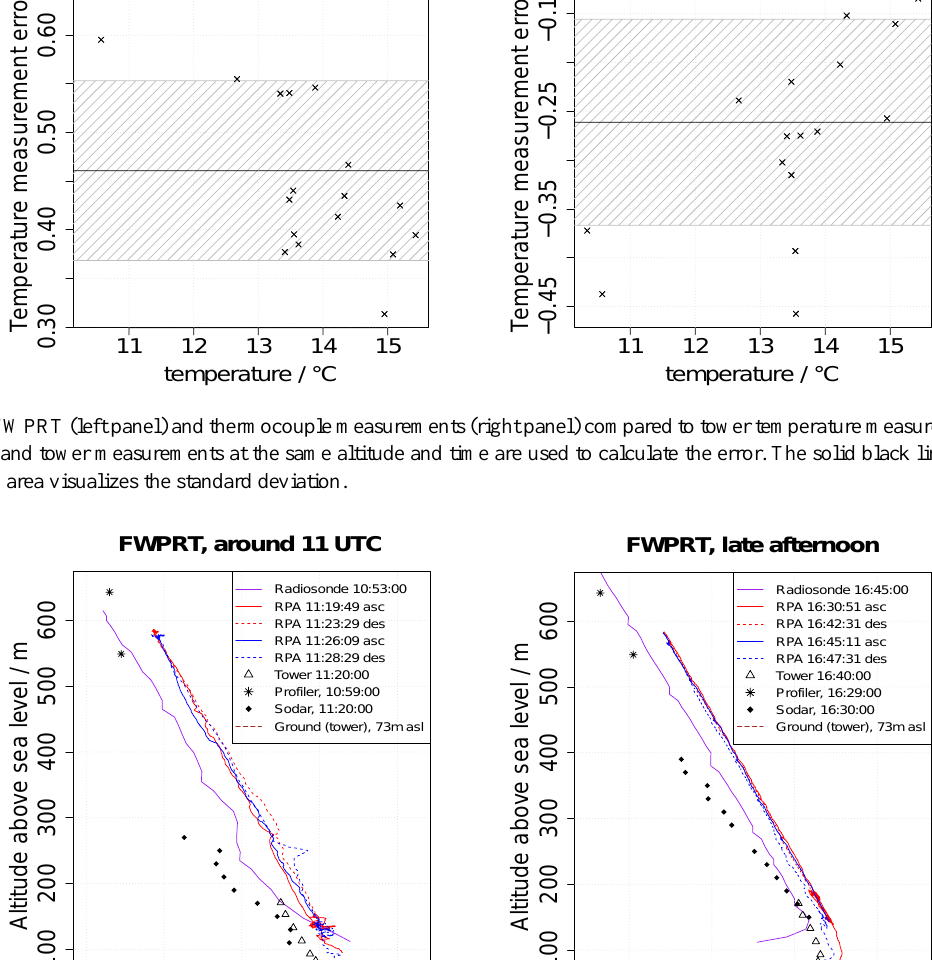
(left panel). It shows mean values for each leg in the